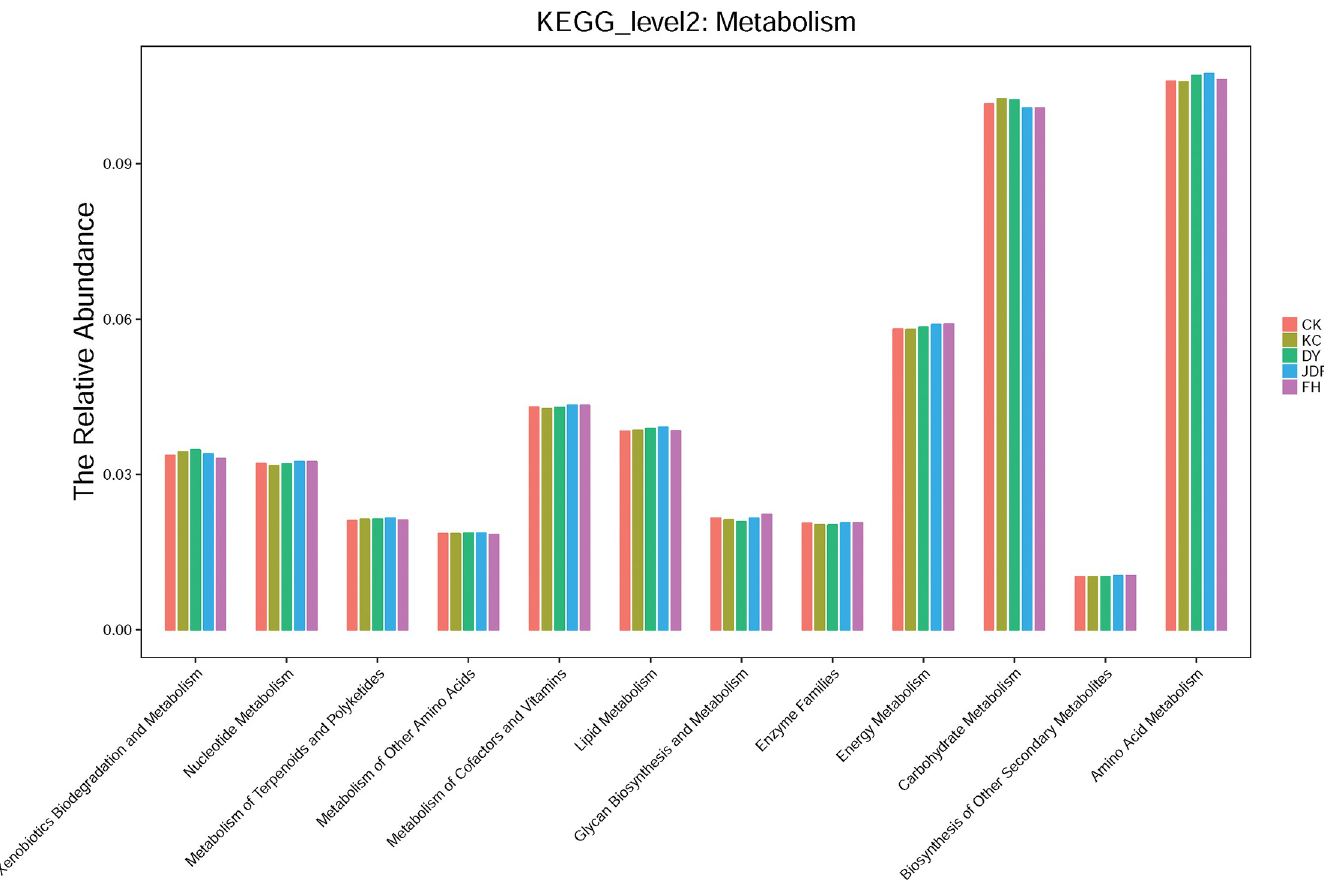
Fig 4. Bacteria functional composition of different soil samples. CK, KC, DY, JDF, and FH groups indicate control, B . subtilis , B . licheniformis , B . amyloliquefacien s, and combined strains treatments, respectively.